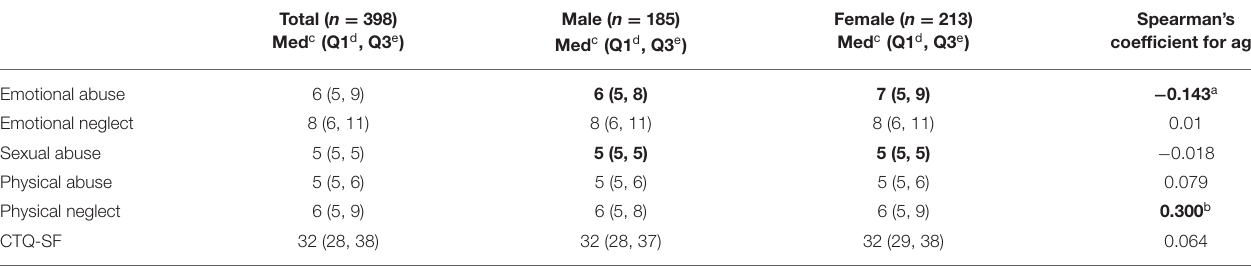
TABLE 1 | ACE factors–median and interquartile range; median and interquartile range by gender; correlation with